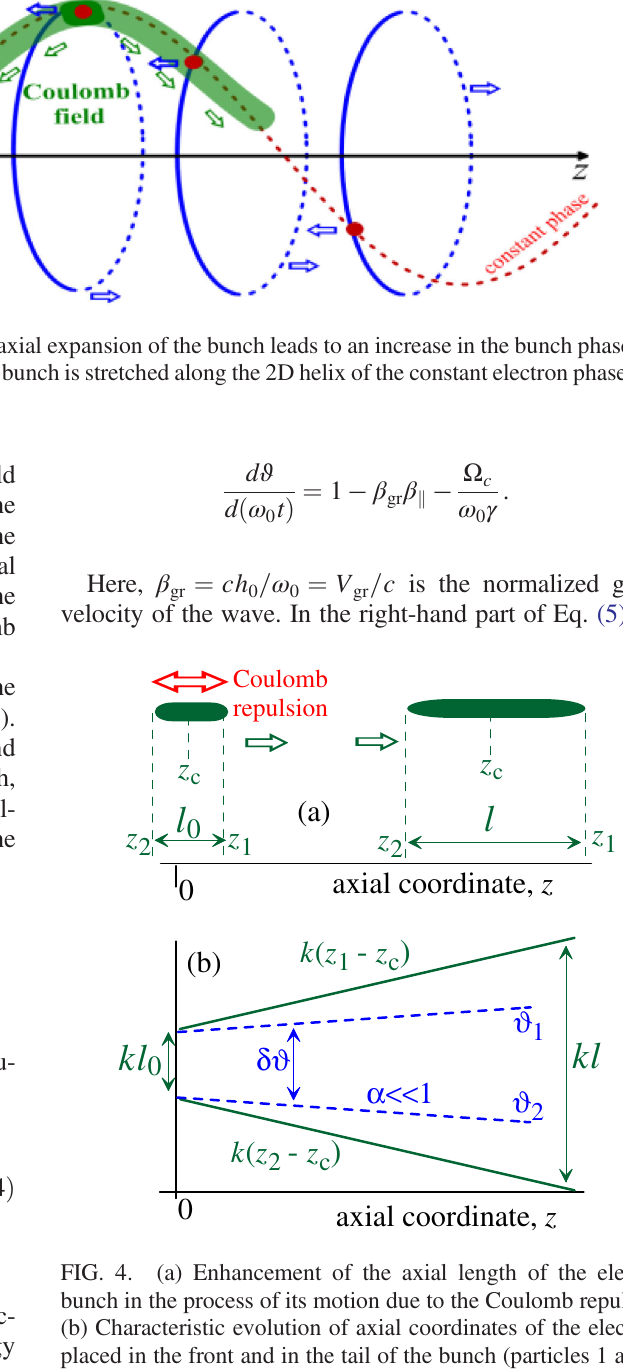
denotes the axial c